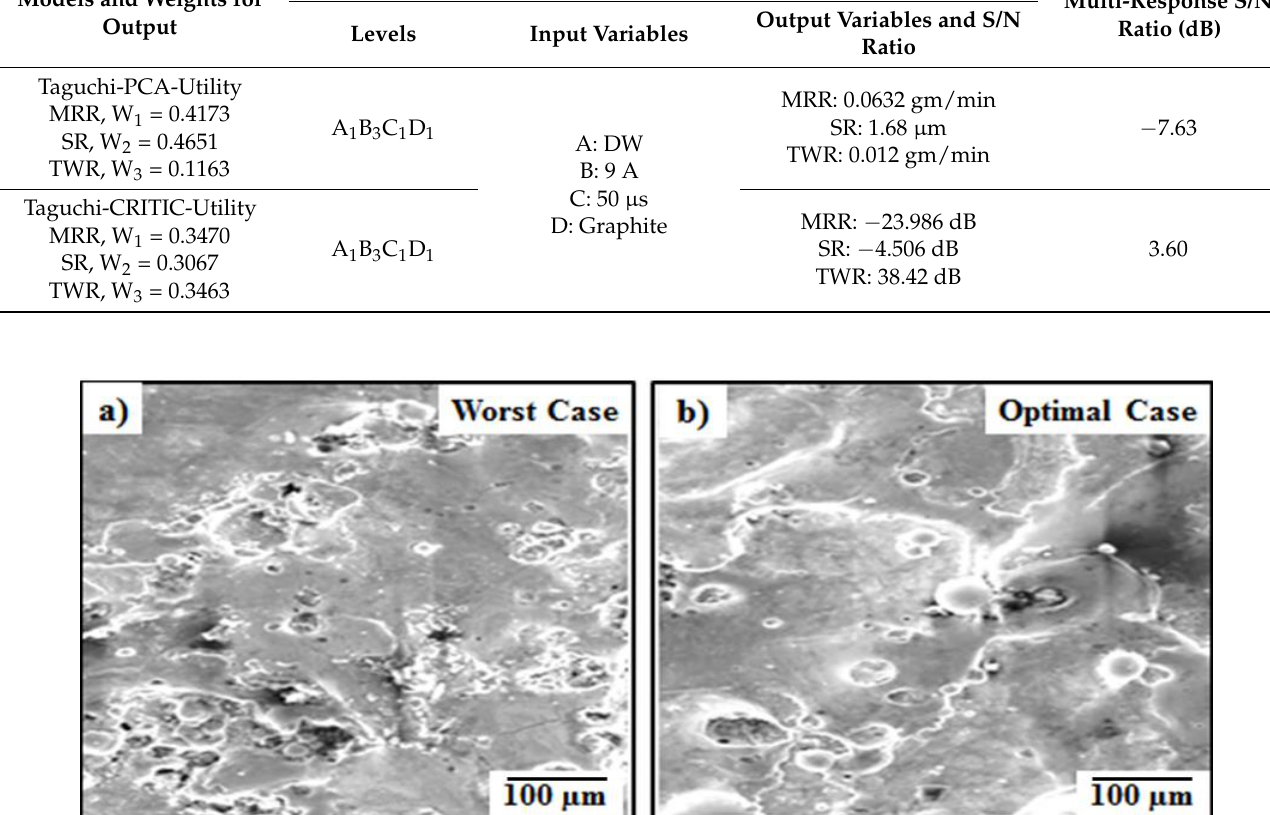
Figure 6. SEM images of HcHcr tool steel in EDM at ( a ) worst conditions (i.e., A 2 B 3 C 3 D 2 ) and ( b ) optimal conditions (A 1 B 3 C 1 D 1 ).